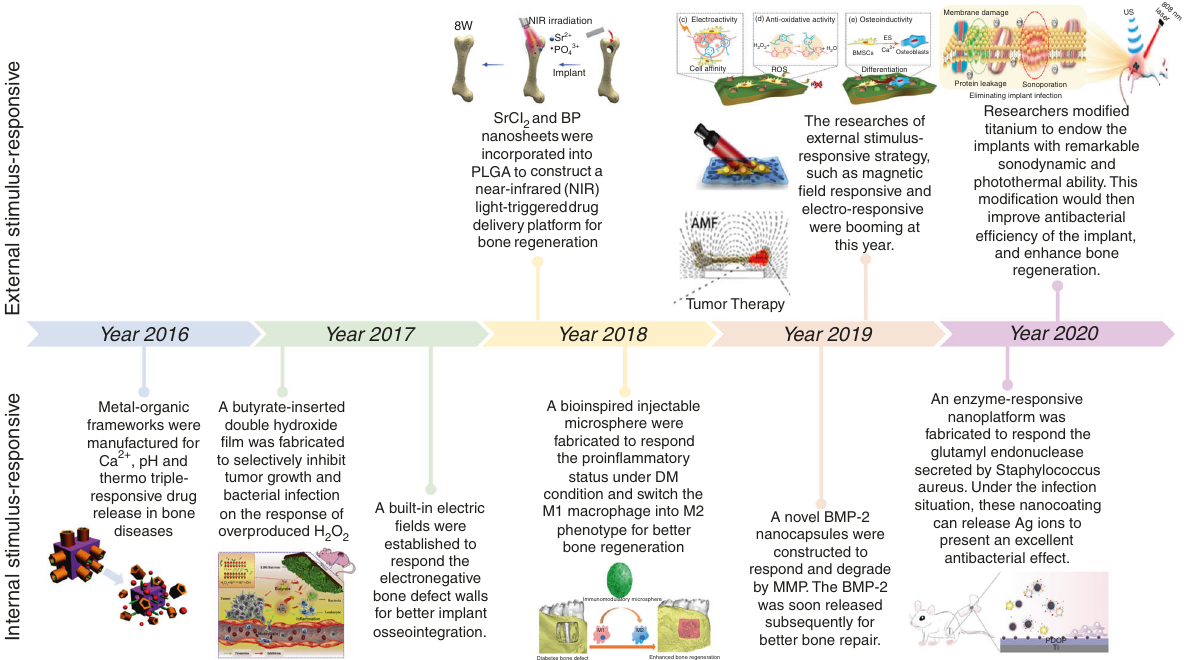
Fig. 2 Timeline of some representative studies of the application of smart stimuli-responsive biomaterials in the past half-decade. Figures for years 2016 – 2020: Image for 2016: reproduced with permission. 115 Copyright 2016, Royal Society of Chemistry; Image for 2017: reproduced with permission. 104 Copyright 2017, Elsevier; Image for 2018: reproduced with permission. 19 Copyright 2018, Elsevier; reproduced with permission. 155 Copyright 2018, American Chemical Society; Image for 2019: reproduced with permission. 54 Copyright 2019, Elsevier; reproduced with permission. 61 Copyright 2019, American Chemical Society; reproduced with permission. 77 Copyright 2019, Wiley-VCH; Image for 2020: reproduced with permission. 31 Copyright 2020, American Chemical Society; reproduced with permission. 126 Copyright 2020,